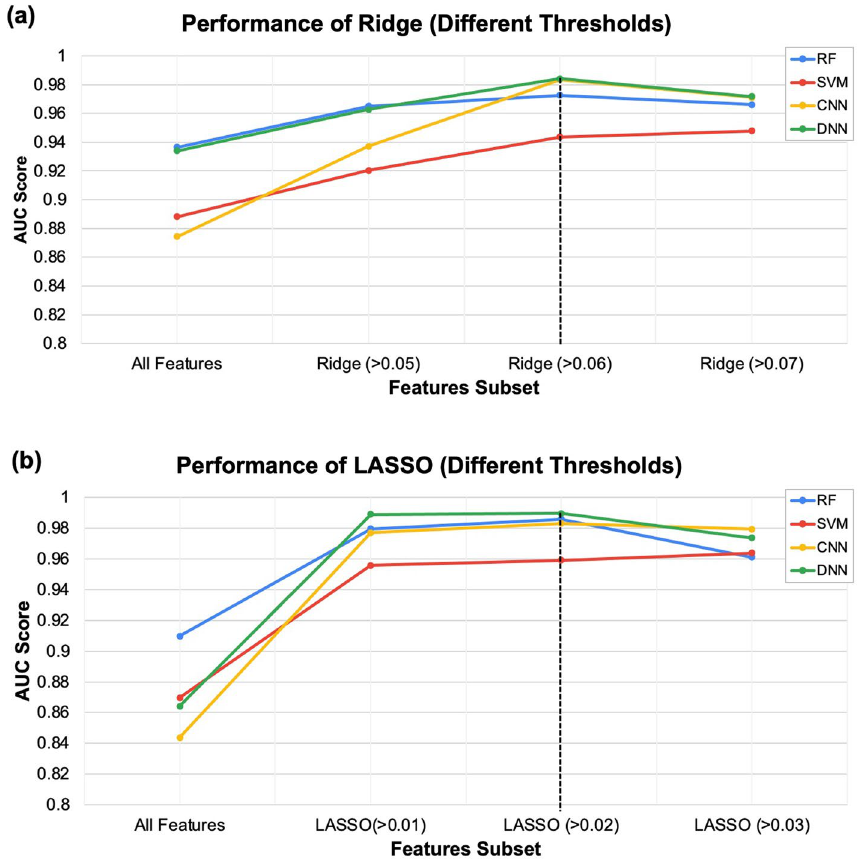
Figure 3. The prediction performance of the list of DEGs selected by ( a ) LASSO (L) and ( b ) Ridge (R) regression algorithms at multiple thresholds for the importance